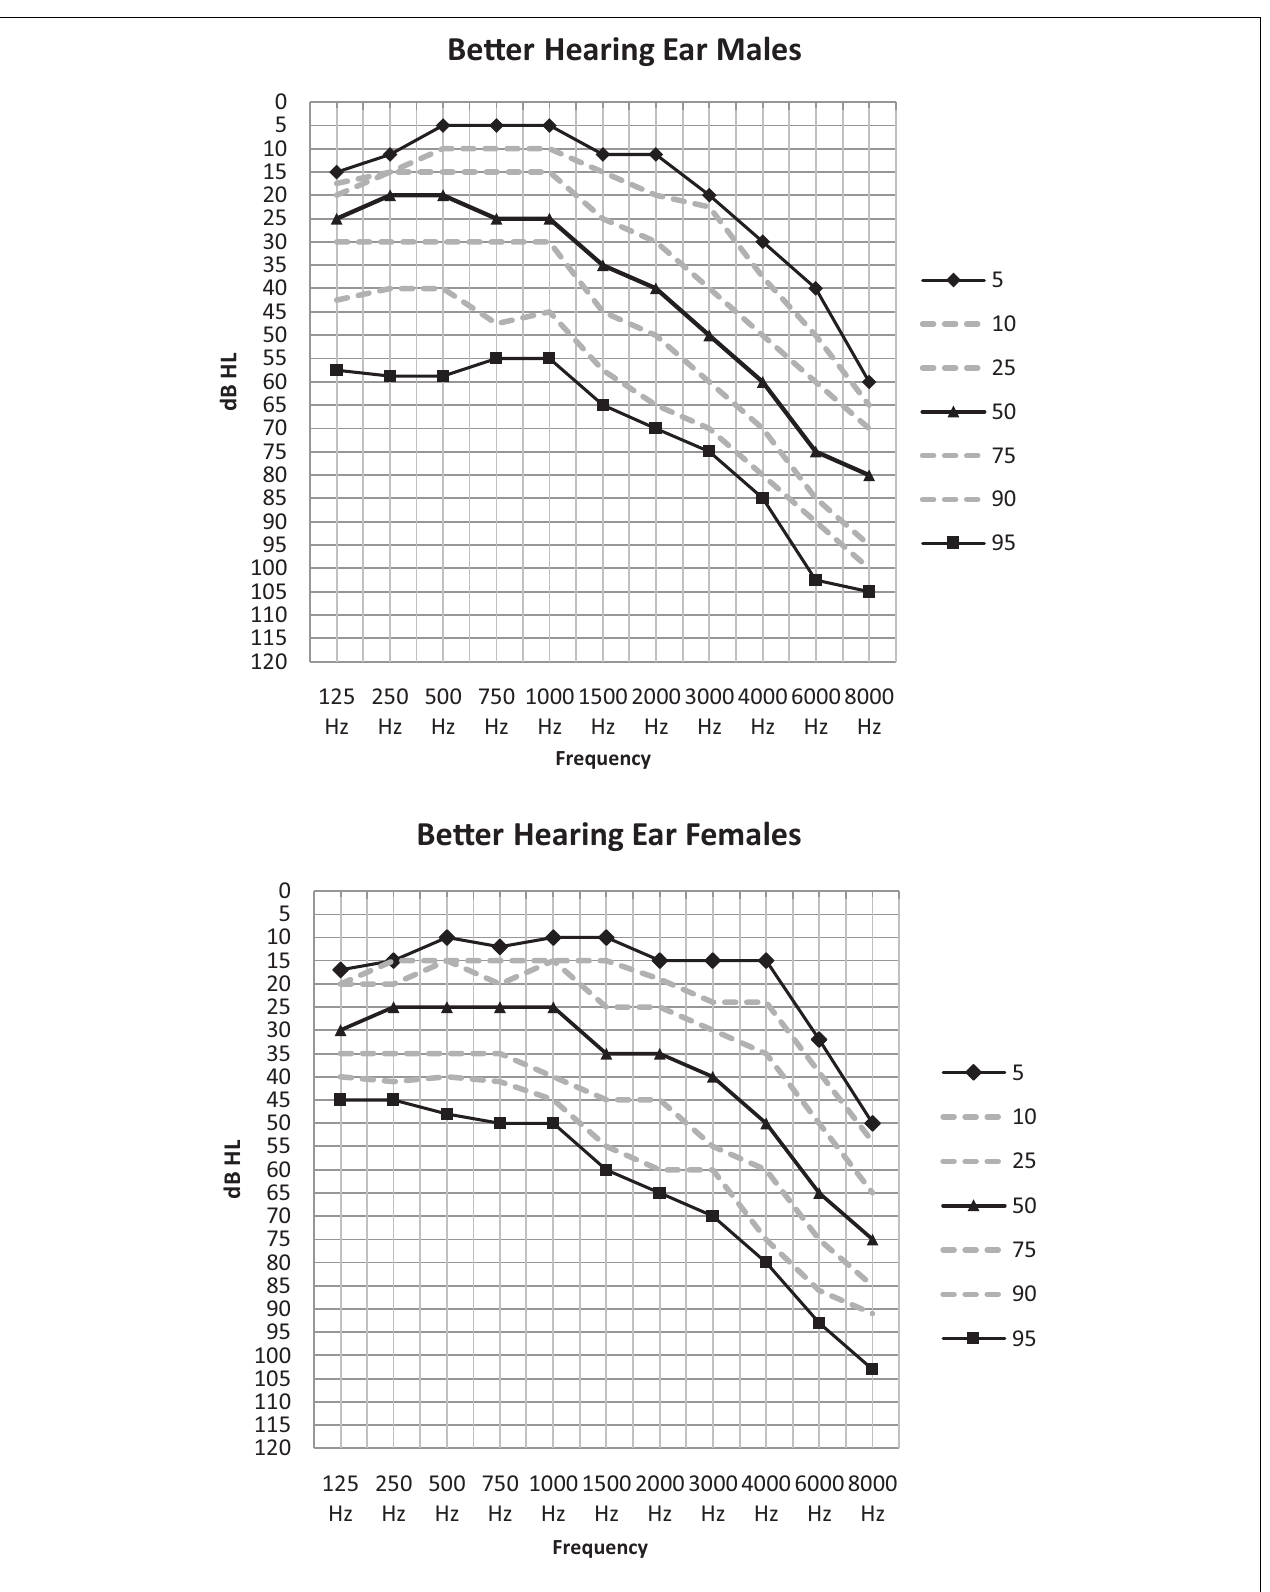
FIGURE 1 | Percentile distribution of the air-conduction thresholds (dB HL) in the better hearing ear in males and females separately.